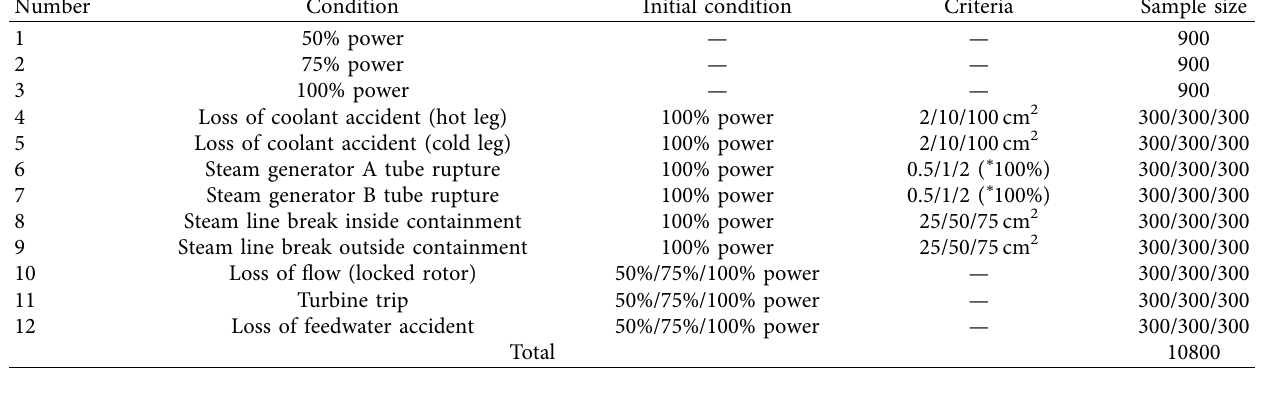
Table 1: Original data.